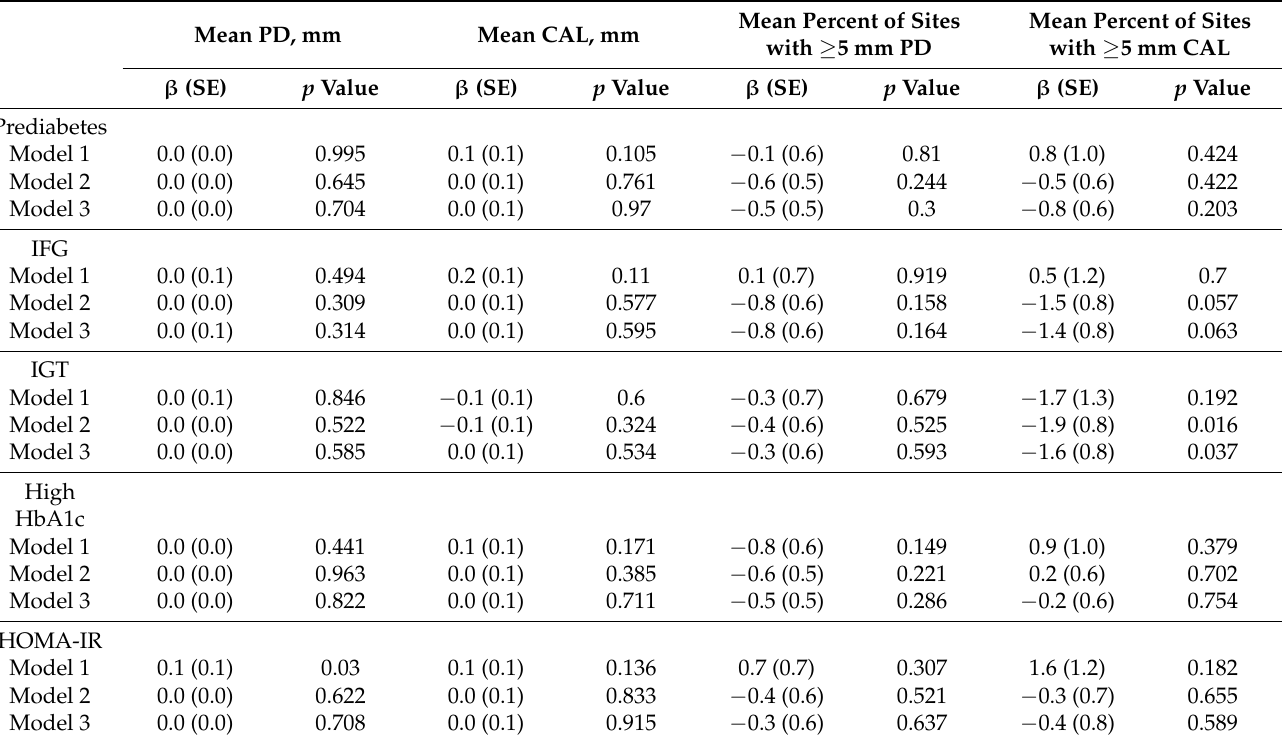
Table 3. Multivariable linear regression models for the relationship between baseline glucose metabolism measures and periodontitis measures at